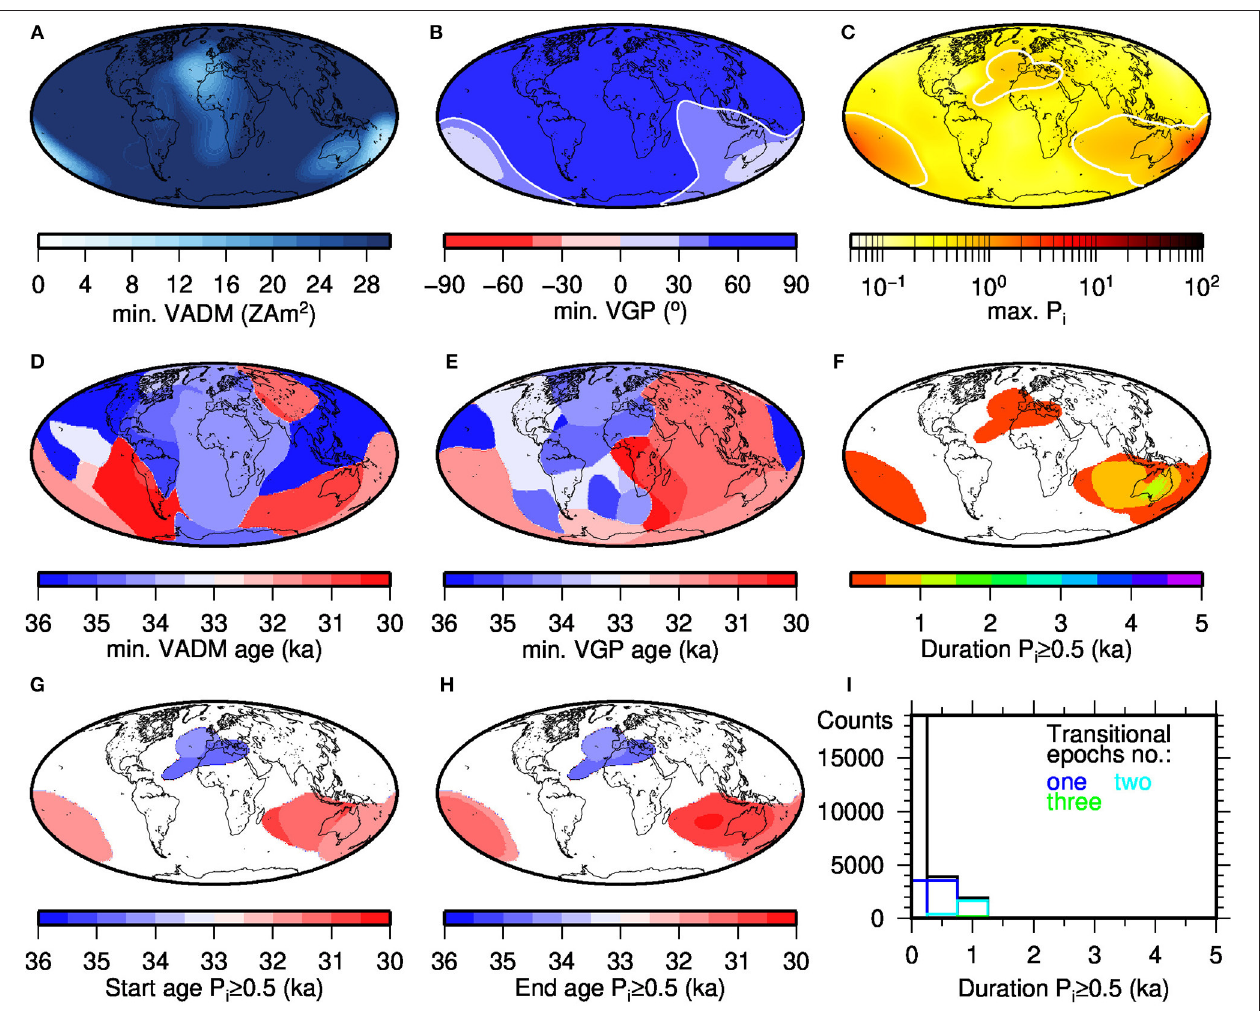
FIGURE 7 | Minimum VADM (A) , VGP ( B , note the non-linear color scale) and maximum P i (C) reached in different areas (at different times) during the Mono Lake excursion; ages where minimum VADM (D) and VGP (E) values are reached; (F) regional duration of the excursion according to P i ≥ 0.5 and earliest (G) and latest (H) age of P i = 0.5 ( P i does not exceed 0.5 in white areas); and histograms of duration of the Mono Lake excursion in 500 years bins (I) according to earliest and latest P i ≥ 0.5 occurrence (black). Colored lines indicate whether P i ≥ 0.5 for the whole duration or whether this time was split into two (cyan) intervals between which P i < 0.5. All results are from our preferred model C